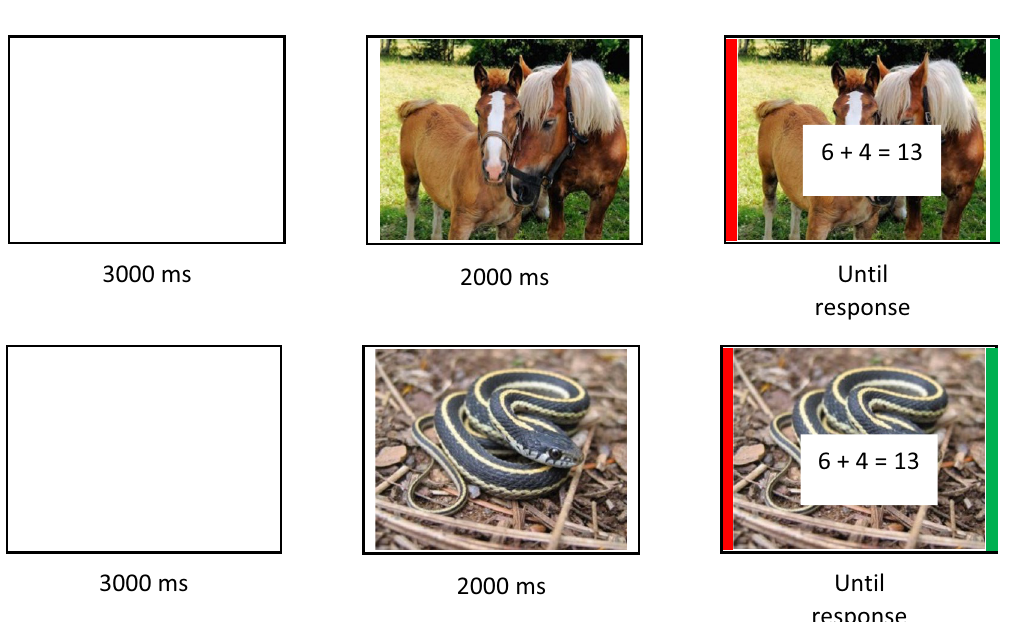
Figure 4. Illustration of procedure (images are from the OASIS database and were not used in this experiment as images used in this experiment were from